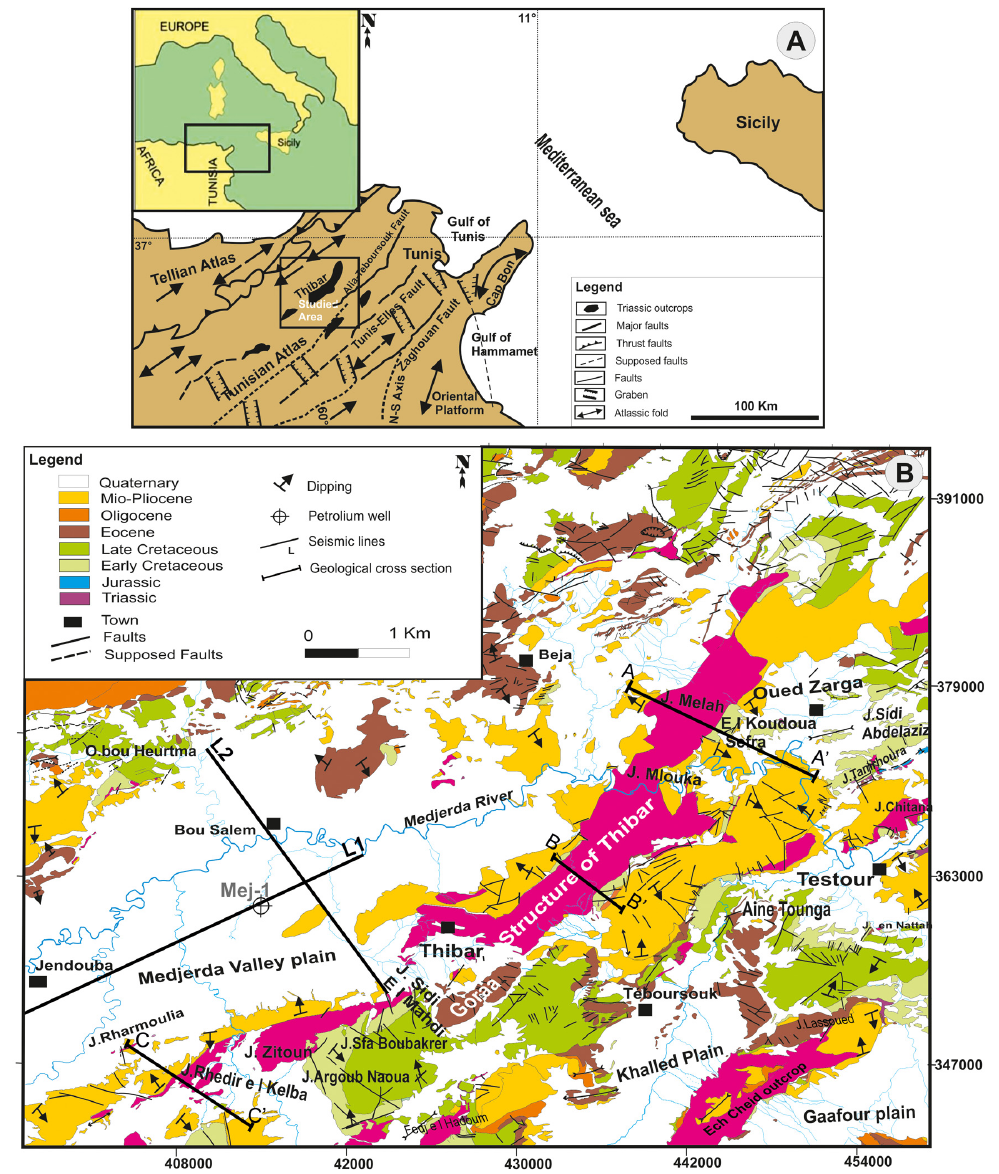
Figure 1. (A) Location of the Thibar area in the Atlas Mountains of northern Tunisia. (B) Geological map of the study area, extracted from 1/50,000 geological maps of Beja [Beily et al. 1982], Oued Zarga [Banjanik and Beily et al. 1985], Teboursouk [Perthuisot 1978], Jendouba [Ben Hadj Ali et al. 1994] and Bou Salem [Rouvier 1995]. This map shows the position of the Mej-1petroleum well and seismic lines (L1 and L2) used in this